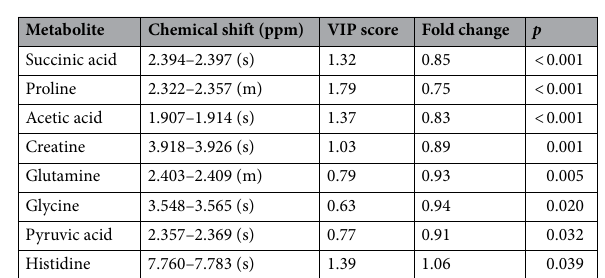
Figure 1. PLS-DA score plots from the analysis of 1 H-NMR spectra using plasma samples and a heat map of eight metabolites significantly differentially-expressed between the major depressive disorder (MDD) patients with full remission (FR) and healthy controls (HCs). ( A ) Two-dimensional scatter plot showing the model’s degree of separation between the two groups: x axis, component 1 (% of total variance); y axis, component 2 (% of total variance). ( B ) Each column represents a plasma sample and each row represents the expression profile of a metabolite. The fold changes from the overall mean concentration are shown in a color-coded manner, with blue representing a decrease and red an increase.